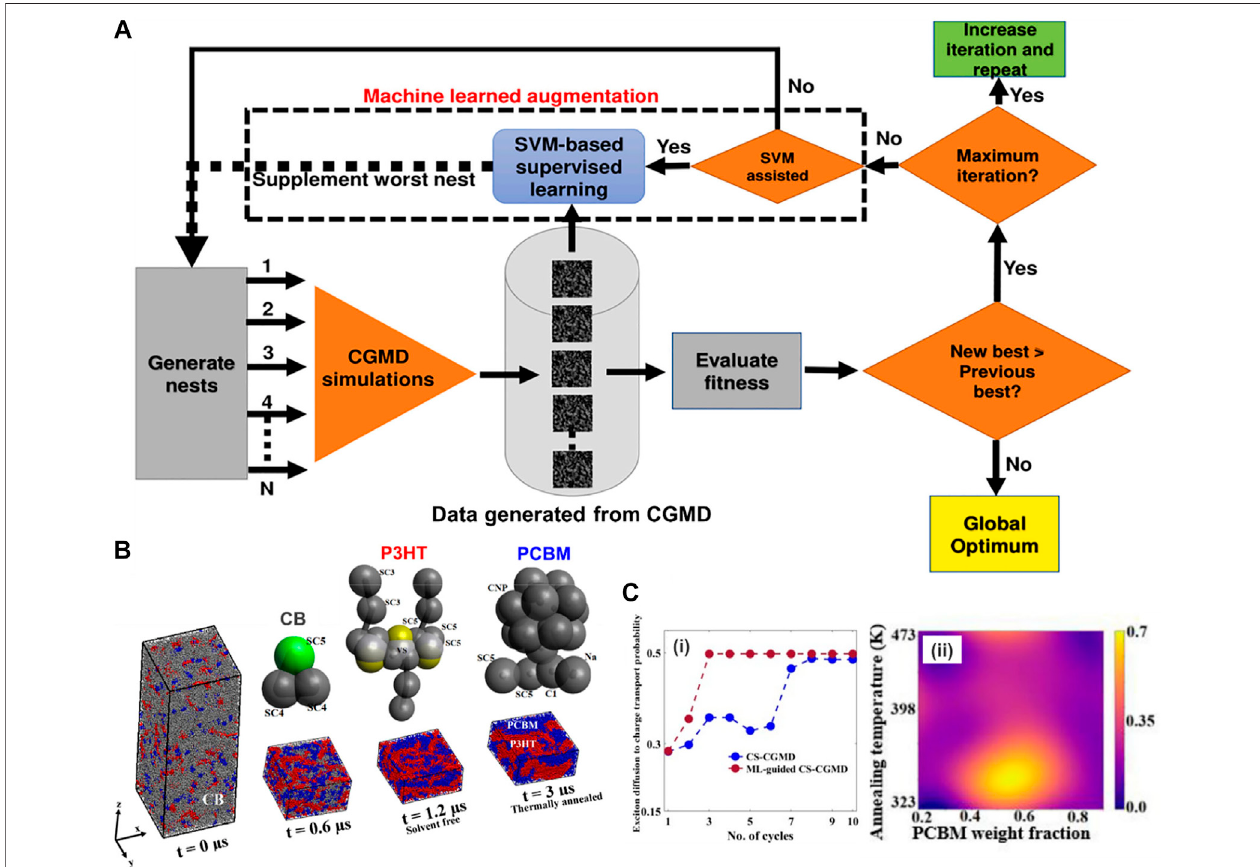
FIGURE 11 | A coupling of ML and CGMD for a design of an organic photovoltaics (OPV) device. (A) Flowchart showcases the coupled ML — CGMD algorithm for OPV design. During each optimization generation, CGMD/ML compares different solutions among different nests and keeps the best candidates. Bad solutions are replaced with newer ones in the design space. The ML augmentation guides the design to the regions of interest (ROI) to replace the worst nests with the better candidates during each optimization cycle. The training dataset is also updated with new CGMD data after each optimization run. The support vector machine (SVM) works as a steerer for the CGMD simulation towards to best candidates. It plays a similar role to the Bayesian optimization as discussed earlier. (B) CGMD representation of phase separation of the mixture of poly-3-hexyl-thiophene (P3HT) (red) and phenyl-C61-butyric acid methyl ester (PCBM) (blue) solvated in chlorobenzene (CB) (gray) from the initial state to partial evaporation of the solvent (t (cid:2) 0.6 µs), solvent-free (t (cid:2) 1.2 µs) and thermally annealed (t (cid:2) 3 µs). CB, P3HT, and PCBM molecules are presented following Martini force fi eld coarse-grained beads. (C) Performance of the integration of ML and CGMD for OPV application. (i) A bivariateoptimizationofPCBMweightfractionandannealingtemperatureforimprovedexcitontransportprobability.TheSVMassisted — CGMDconvergedmuchfaster than the traditional approach after only 3 cycles; (ii) Landscape of the Pareto solutions from ML-CGMD integration for multi-objective OPV design: improved charge transport probability and increased ultimate tensile strength which are evaluated using CGMD simulations. Figure was reproduced from Ref. (Munshi et al., 2021) with permission.